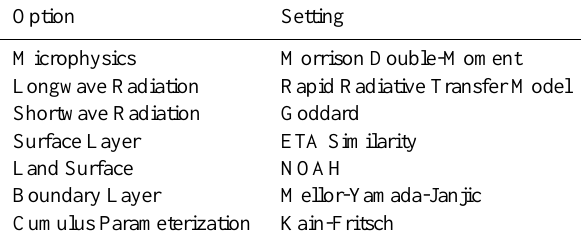
Table 1. WRF physics options used in this study. See Skamarock et al. (2008) for details about each